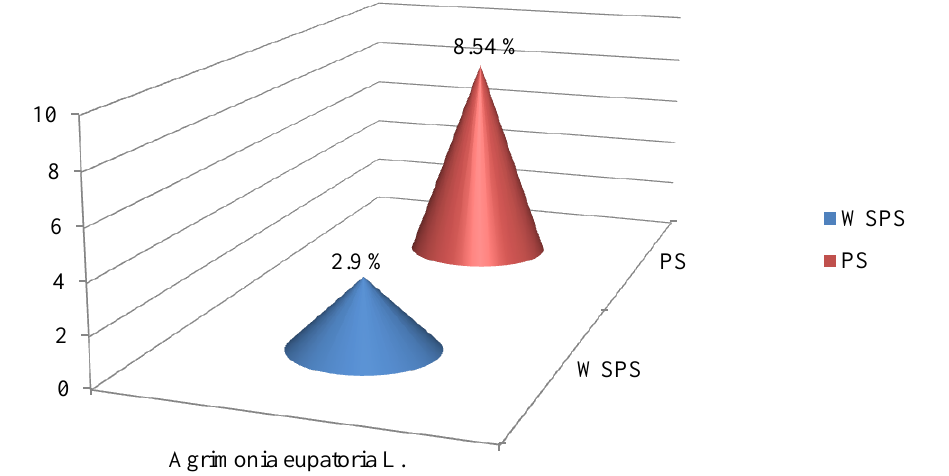
Fig. 5. Water-soluble polysaccharides (WSPS) and pectin substances (PS) in Agrimonia eupatoria